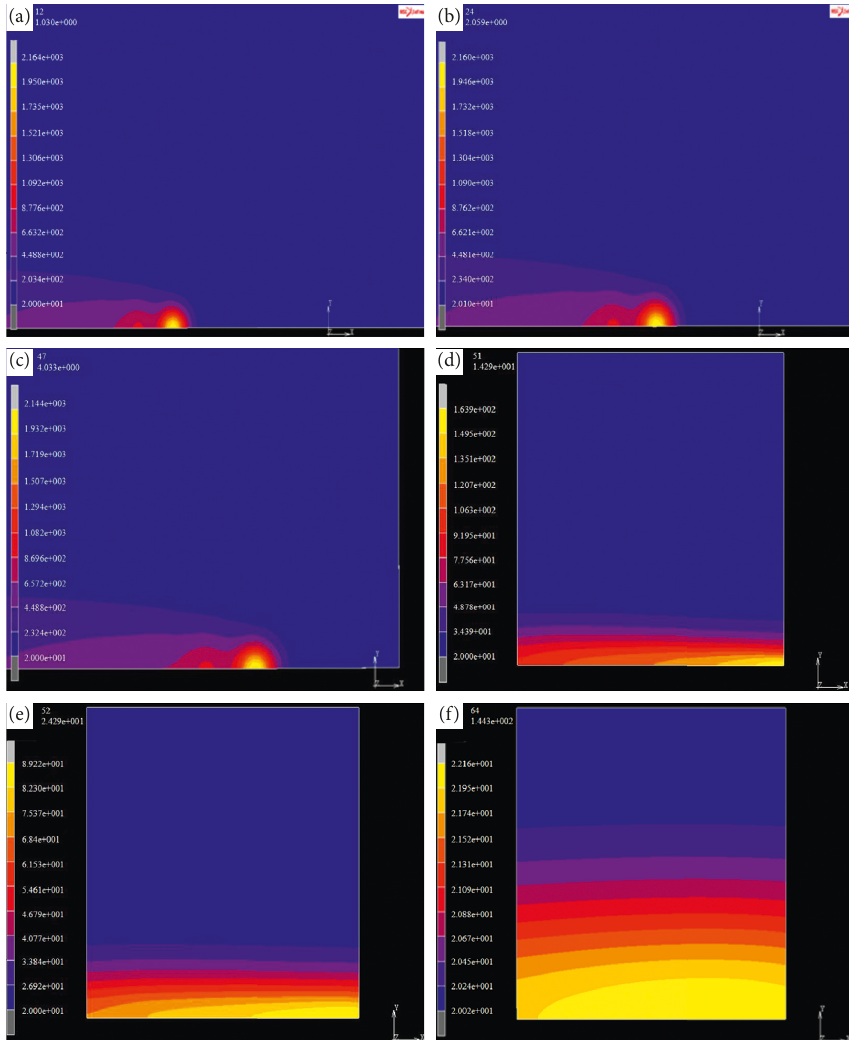
Figure 14: The temperature distribution in the laser welding process for different times: (a) t � 1.03s, (b) t � 2.06 s, (c) t � 4.00s, (d) t � 14.29s, (e) t � 24.29s, and (f) t �